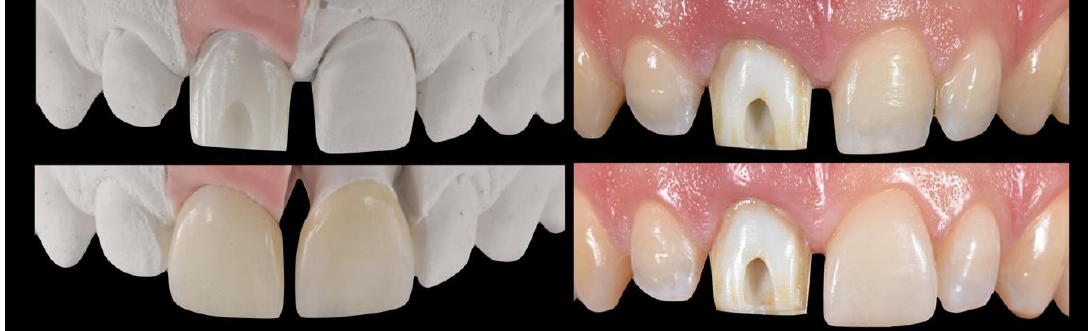
Figure 18. Prosthesis design and clinical installation. Two veneers cemented on both implant abutment and adjacent tooth #21 have been utilized to enhance the esthetic result.